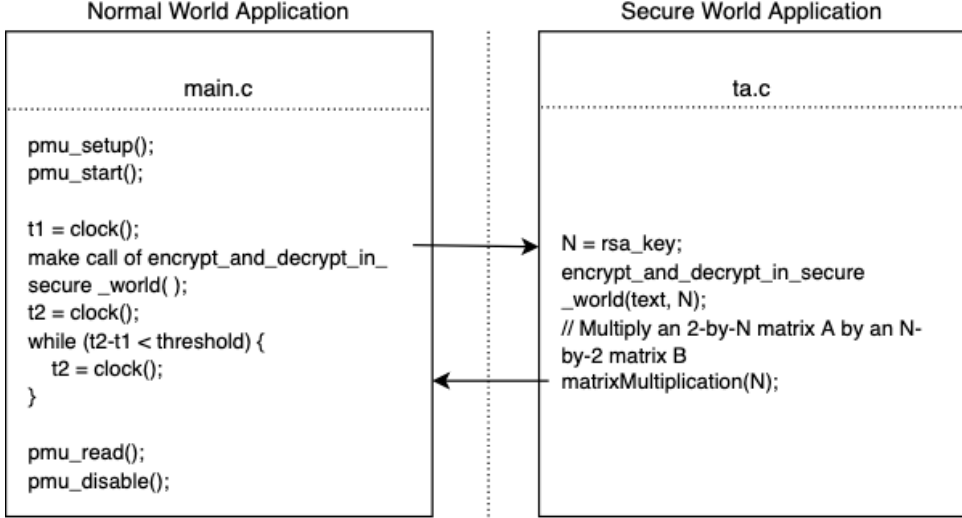
Figure 4. The code used in the semi-synchronous attack